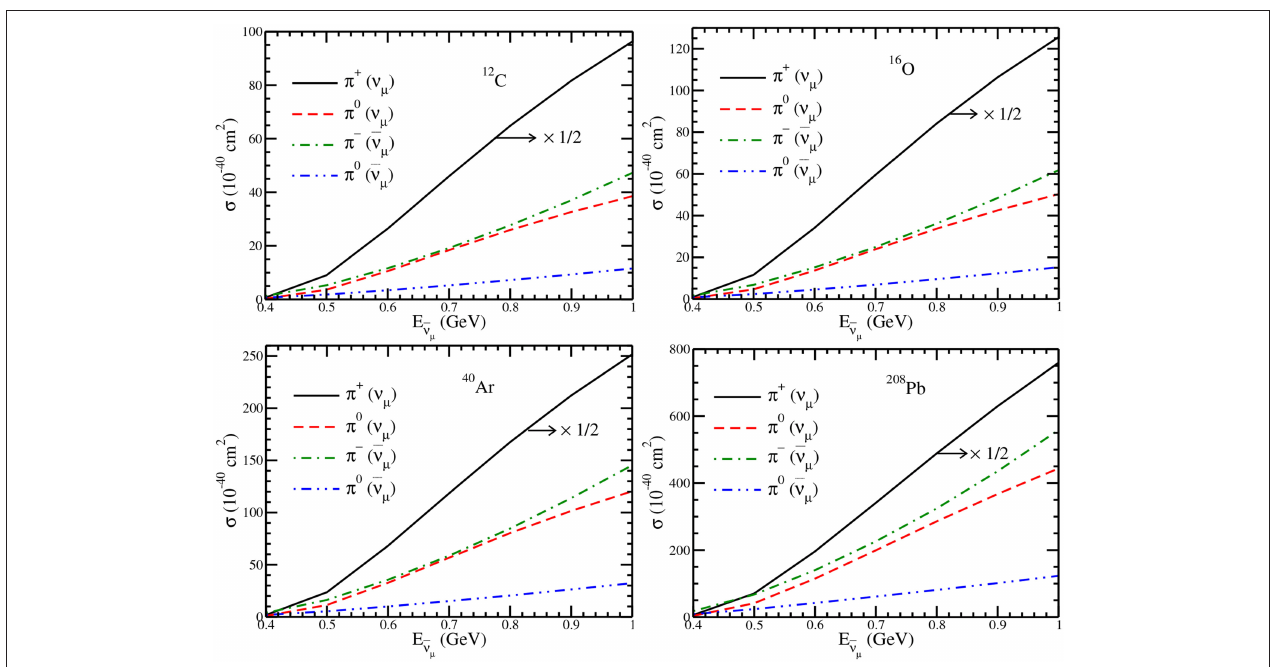
ν µ induced π − and π o production cross sections. For ν µ scattering the FIGURE 20 | Results for the ν µ induced π + and π o production cross sections and ¯ ν µ scattering the contribution to the pions is coming from the 1 as well as the hyperons. The results are contribution to the pions is coming from the 1 only, while for ¯ presented for 12 C, 16 O, 40 Ar, and 208 Pb with NME+FSI. Notice that π + production cross section has been reduced by half to bring it on the same scale.